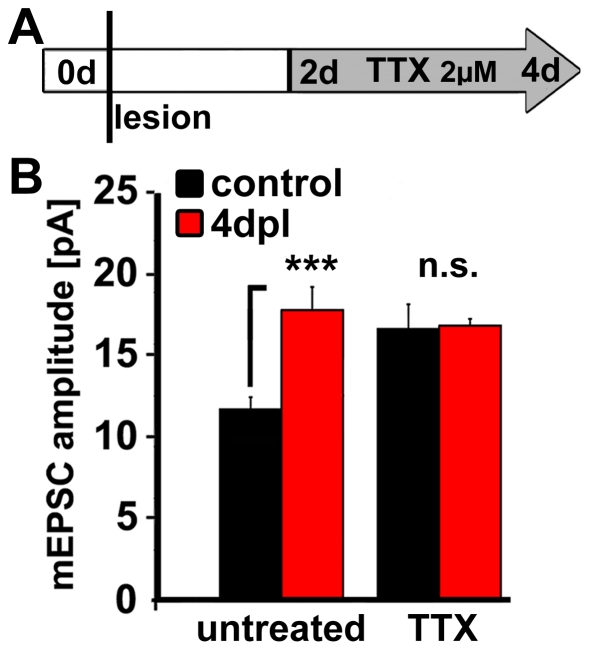
Denervation induces homeostatic synaptic scaling.(A, B) Treatment of denervated cultures with the sodium channel blocker tetrodotoxin (A; TTX 2 µM, 2 d) did not significantly change the denervation-induced compensatory increase in excitatory synaptic strength (B; n = 5 cultures per group), indicating that granule cells utilize, at least in part, similar mechanisms to adjust their excitatory synaptic strength in a homeostatic manner following denervation and TTX-treatment.